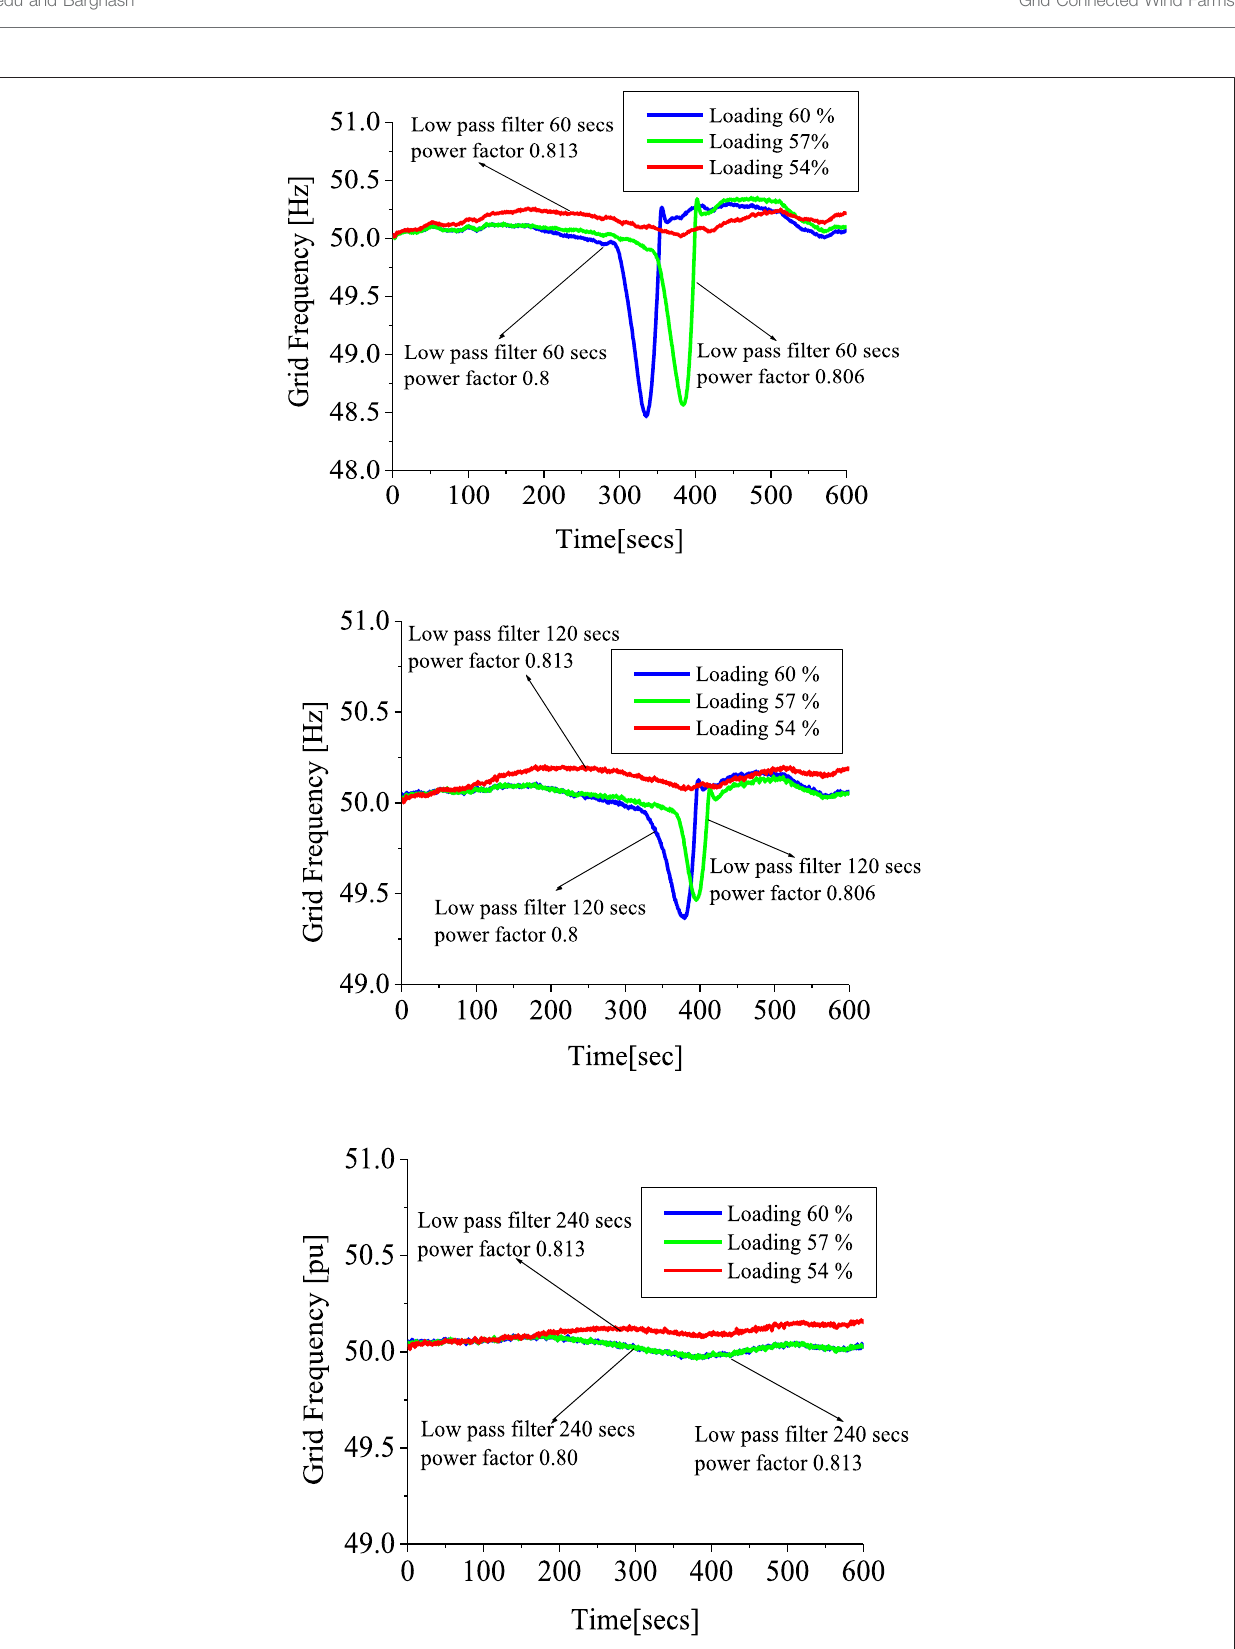
Frontiers in Energy Research |